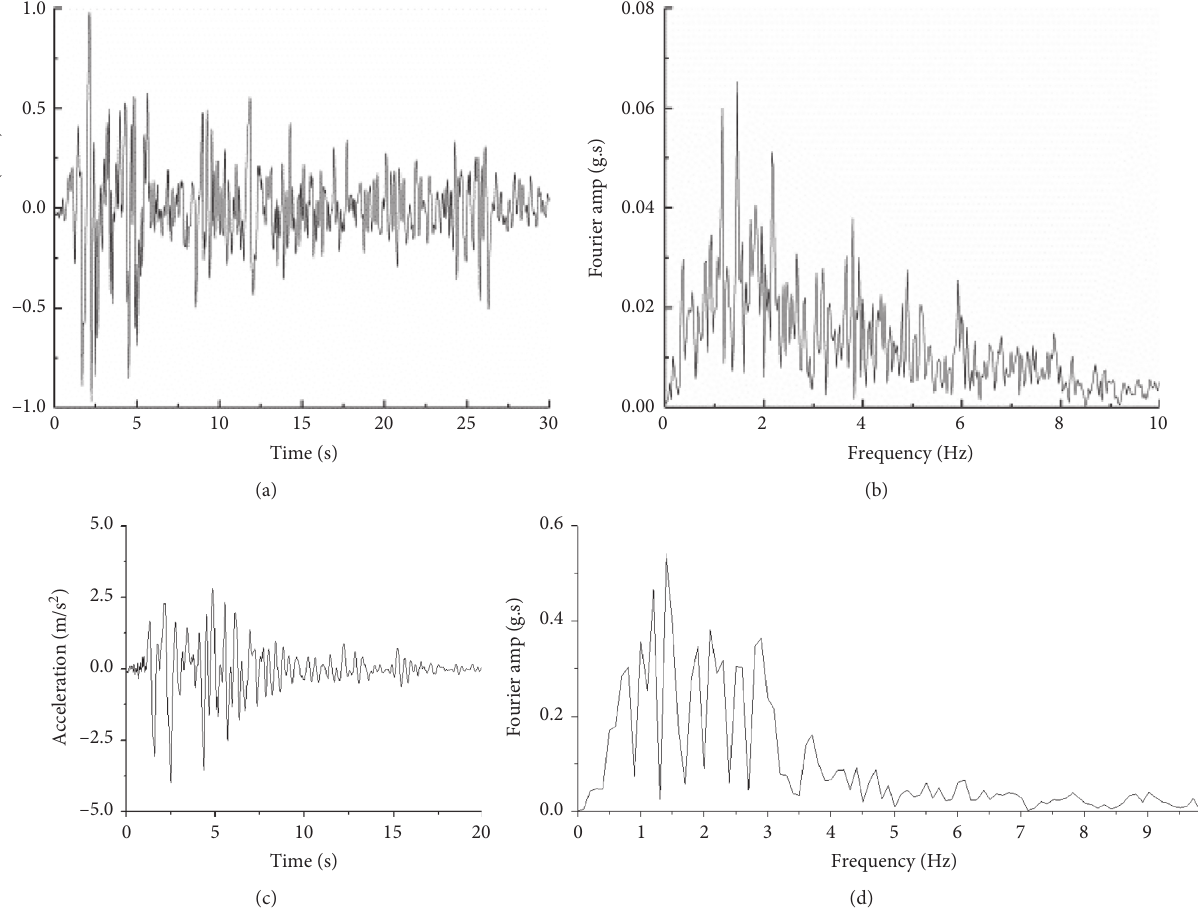
Figure 3: Time history and spectrum curves of El-Centro wave and Kobe wave. (a) Time history curve of El-Centro wave. (b) Frequency curve of El-Centro wave. (c) Time history curve of Kobe wave. (d) Frequency curve of Kobe